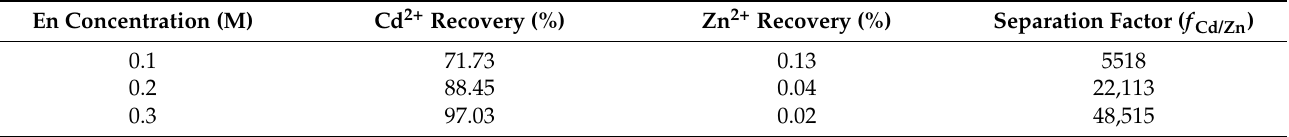
Table 6. Cd and Zn recovery (% of total input) by En elution from I − -loaded ZB-2